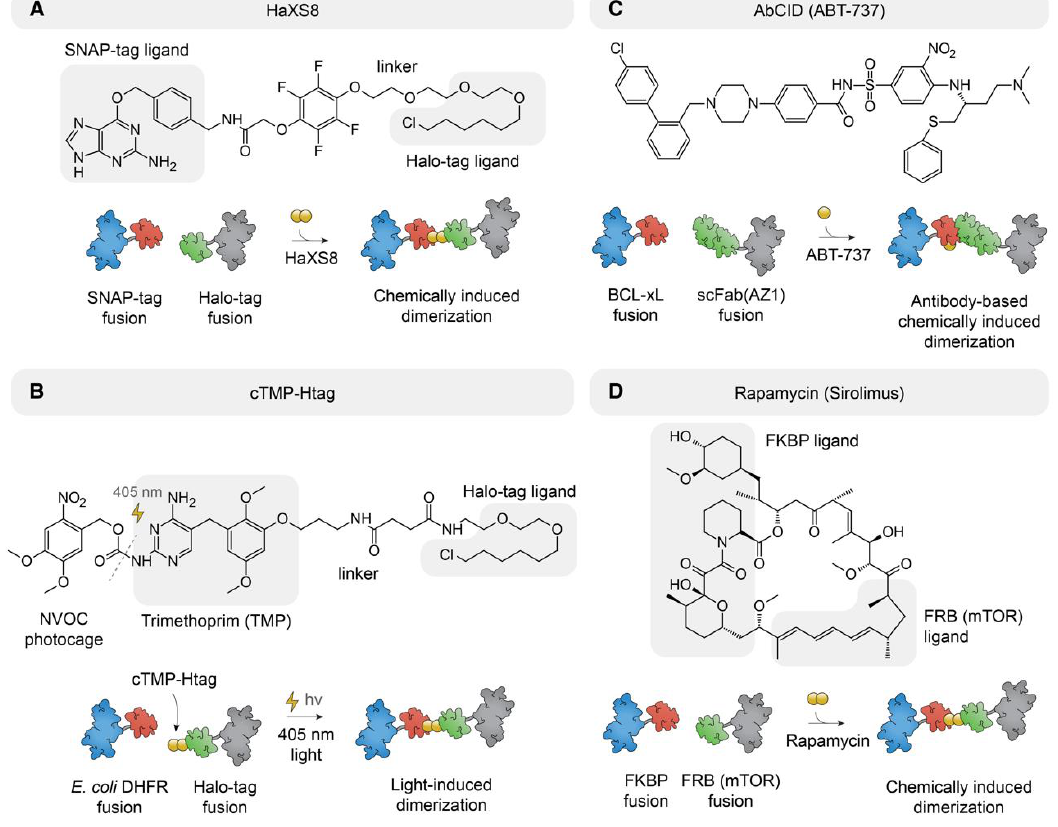
Figure 5. Heterobifunctional small molecules for chemically induced proximity. ( A ) Chemically induced dimerization of SNAP-tag and Halo-tag with HaXS8; ( B ) Antibody-based chemically induced dimerization with AbCID (ABT-737); ( C ) Light-induced dimerization of E. coli dihydrofolate reductase (DHFR) and Halo-tag with cTMP-Htag; ( D ) Chemically induced dimerization of FRB and FKBP with rapamycin.